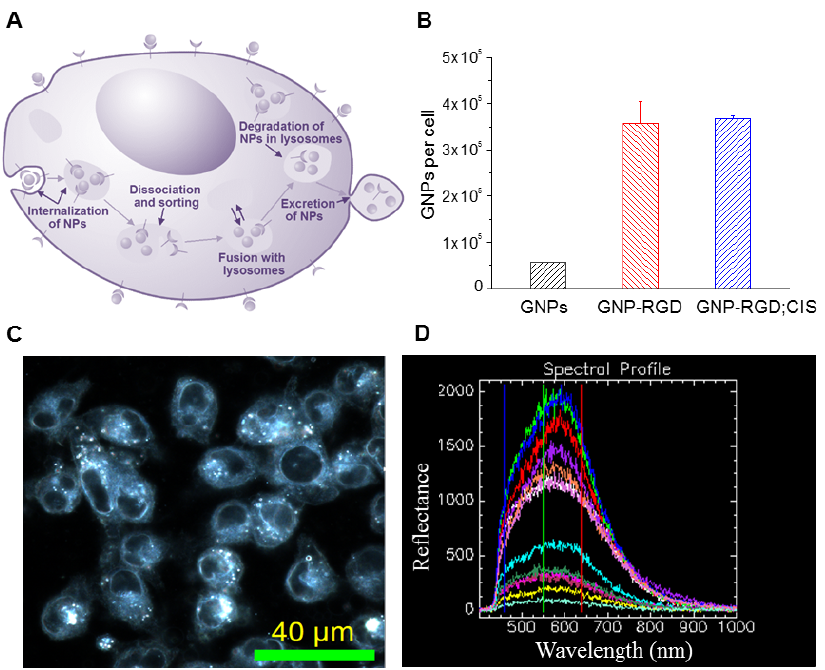
Figure 2. ( A ) Cell uptake pathway of GNPs; ( B ) Accumulation of GNP constructs; ( C ) Dark field image of cells incubated with GNP constructs. Scale bar = 40 µm; ( D ) Few spectra of GNP constructs from ( C ).